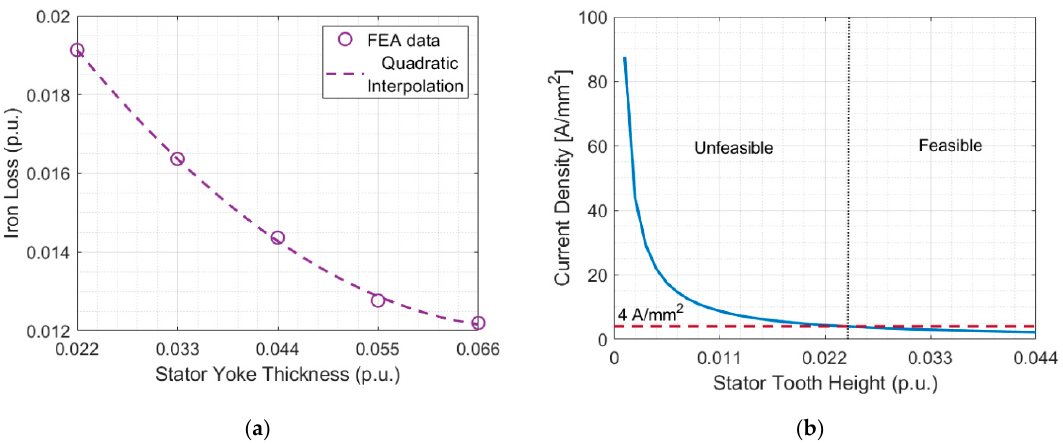
Figure 9. Trade-off 1 plots: ( a ) iron loss vs. stator yoke thickness (in per unit with respect to OD ); ( b ) current density vs. stator tooth height (in per unit with respect to OD ).